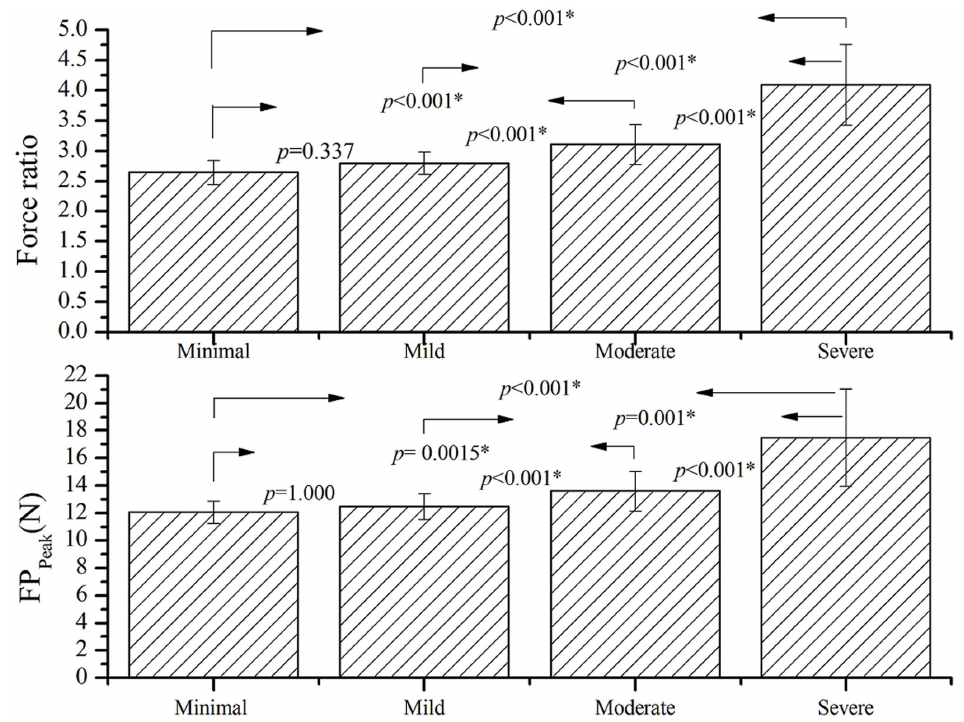
Figure 4. Mean ( 6 SD) of force ratio and FP Peak for various grades of CTS severity based on nerve conduction study. There were statistical differences in the results of functional sensibility between each pair of the CTS subgroups except between the subgroup with minimal and mild severity. (Statistical analysis method: the mixed effect model with Bonferroni multiple comparisons test; the significance threshold for Bonferroni post hoc test was set at p =0.008.).